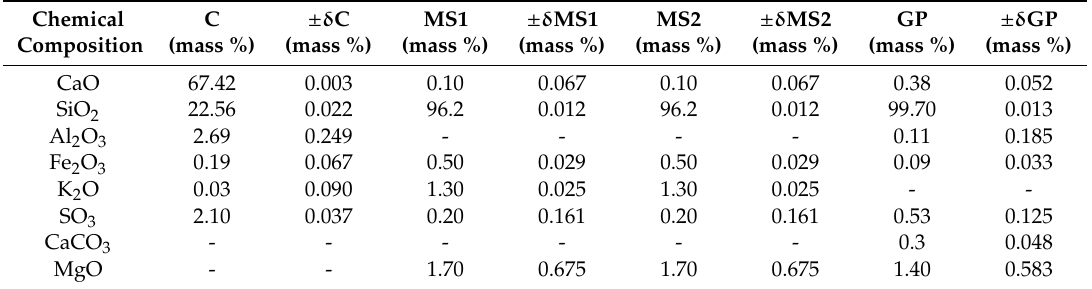
Table 1. Chemical compositions of cement (C), microsilica (MS1 and MS2) and glass powder (GP). Chemical